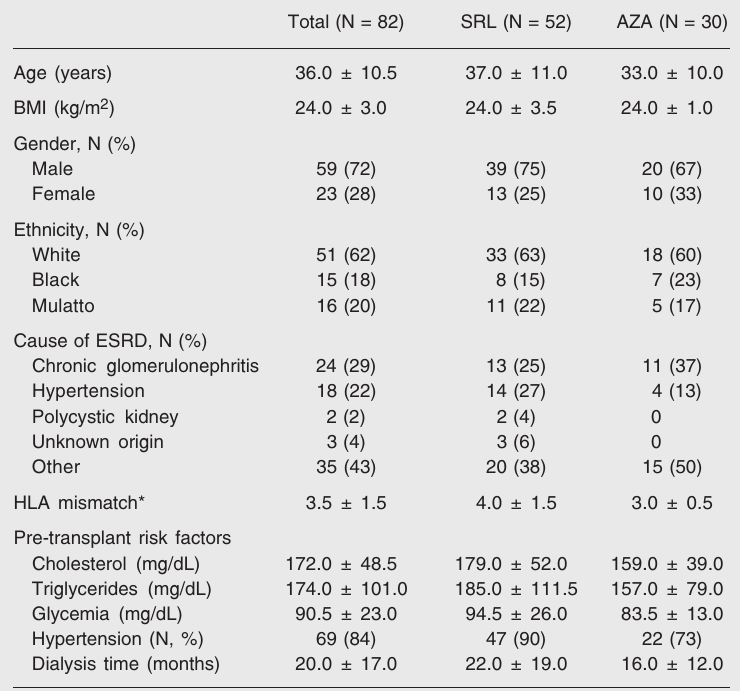
Table 1. Demographic characteristics of the transplant